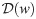
Network evolution.Plot of D(w), the information flow in two consecutive time windows, defined in Eq (5), at time differences δ = 2 and δ = 3. Each time window w is 500 days long. The date associated to each w is the middle of the time window considered. The x-axis tick marks represent the first of March of every year. This quantity measures the evolution of the detected structure of influences. We observe a smooth behavior, meaning that structures in consecutive time windows are similar, except for during crises where more pronounced market readjustment take place.